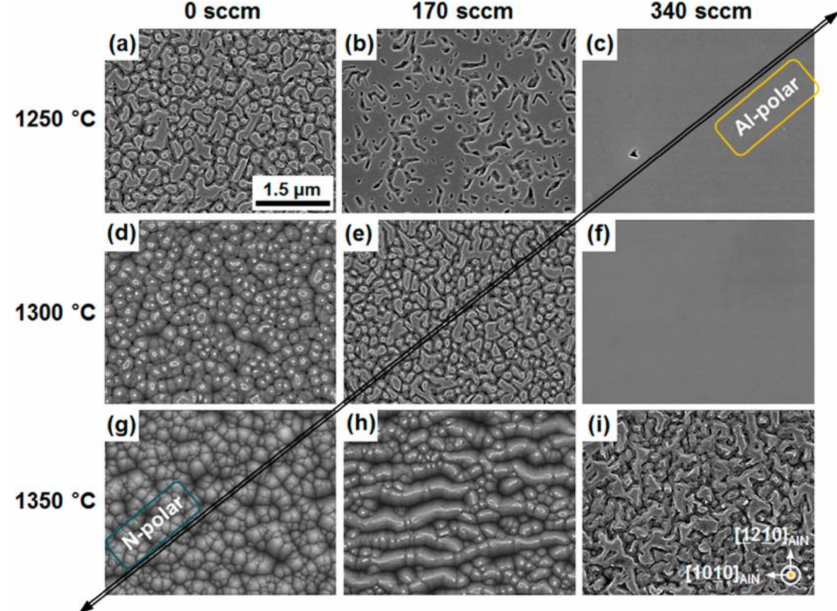
Figure 2. ( a – i ) Plan-view scanning electron microscope (SEM) images of KOH-etched AlN/sapphire templates, which were grown on different conditions (Temperatures = 1250, 1300, and 1350 ◦ C; TMAl flows = 0, 170, and 340 sccm). Reprinted with permission from [25]. Copyright {2015} American Chemical